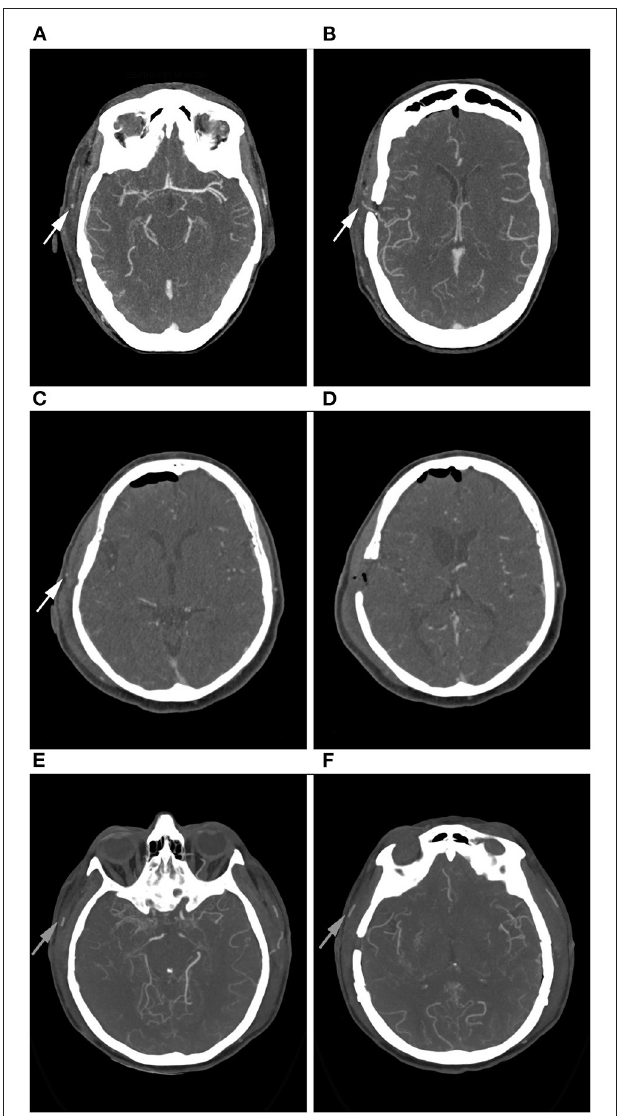
FIGURE 2 | Example of right-sided STA-MCA bypasses in CTA. (A,B) : Bypass is patent. The proximal (A) and the distal (B) parietal branch of the STA are visible (arrows). (C,D) : Bypass of uncertain patency. Only the proximal branch of the STA is visible ( C , arrow), the distal branch is not clearly contrasted (D) . (E,F) : Bypass appears occluded. Neither the proximal (E) nor the distal (F) parietal branch of the STA are contrasted. Good contrast enhancement of the frontal branch of the STA (arrows). FIGURE 3 | Follow-up of a left-sided STA-MCA bypass shown to be occluded